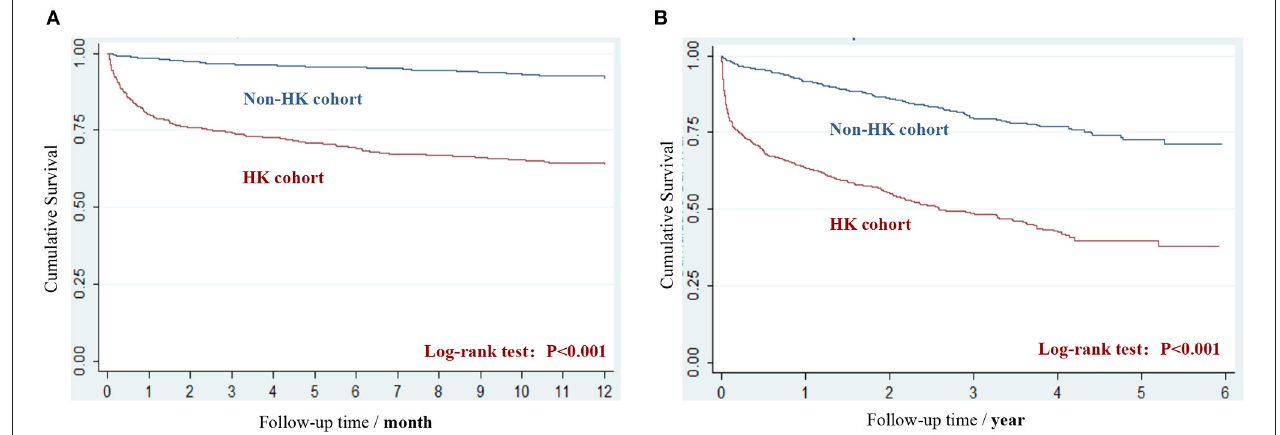
FIGURE 1 | The Kaplan-Meier survival curves of HK and non-HK cohort. (A) Survival during the 12-month follow-up period. (B) Survival during the period from index date to the end of study.